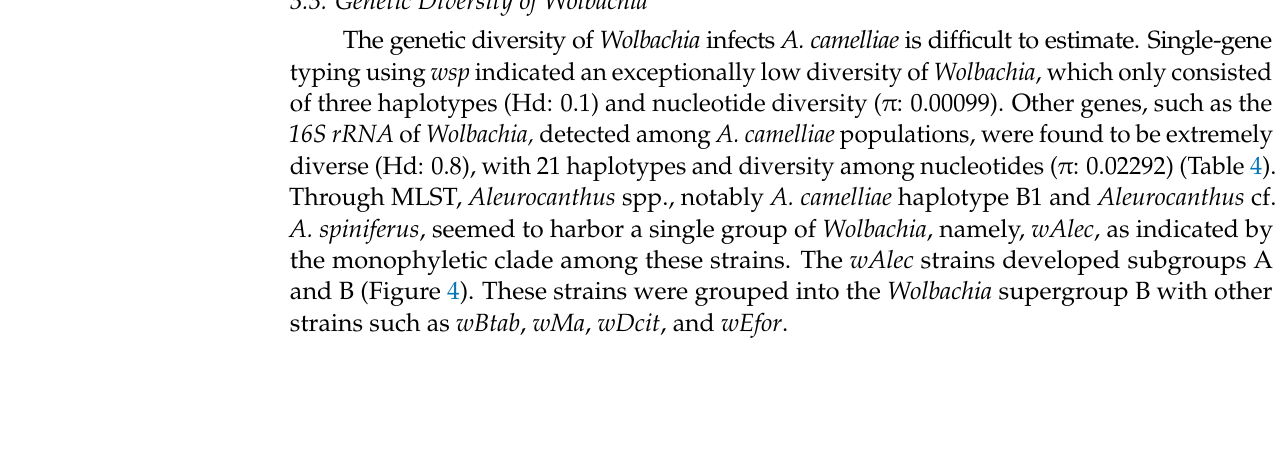
Figure 4. ML phylogenetic tree of Wolbachia MLST genes. The tree was constructed based on multi- ple alignments of concatenated DNA sequences encoding gatB , coxA , hcpA , ftsZ , and fbpA in ~2 kbp. Bootstrap values are shown for all nodes. A single lineage of wAlec (green line) evolved into two